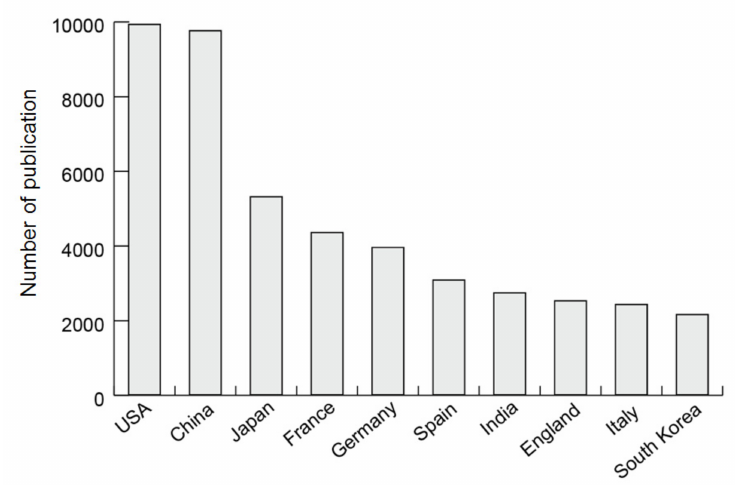
Figure 2. Number of publications from each country in zeolite research